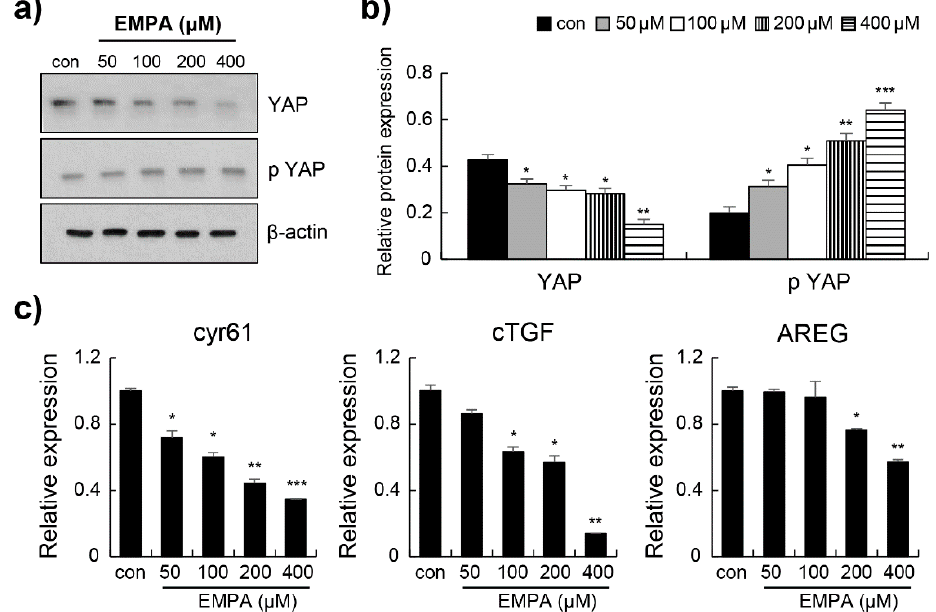
Figure 4. Empagliflozin decreased Yes ‐ associated protein (YAP) expression in LX ‐ 2 cells. ( a ) The representative protein expression of YAP and phospho ‐ YAP was determined using Western blot. ( b ) Quantitation and normalisation of phospho ‐ YAP to total YAP or total YAP to β‐ actin from a. ( c )